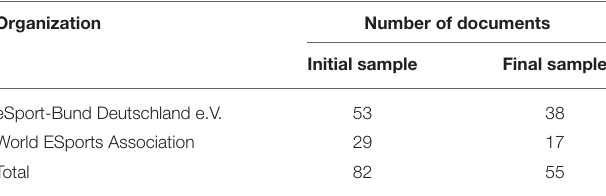
TABLE 1 | Legitimacy strategies and characteristics. TABLE 2 | Number of documents by initial and final